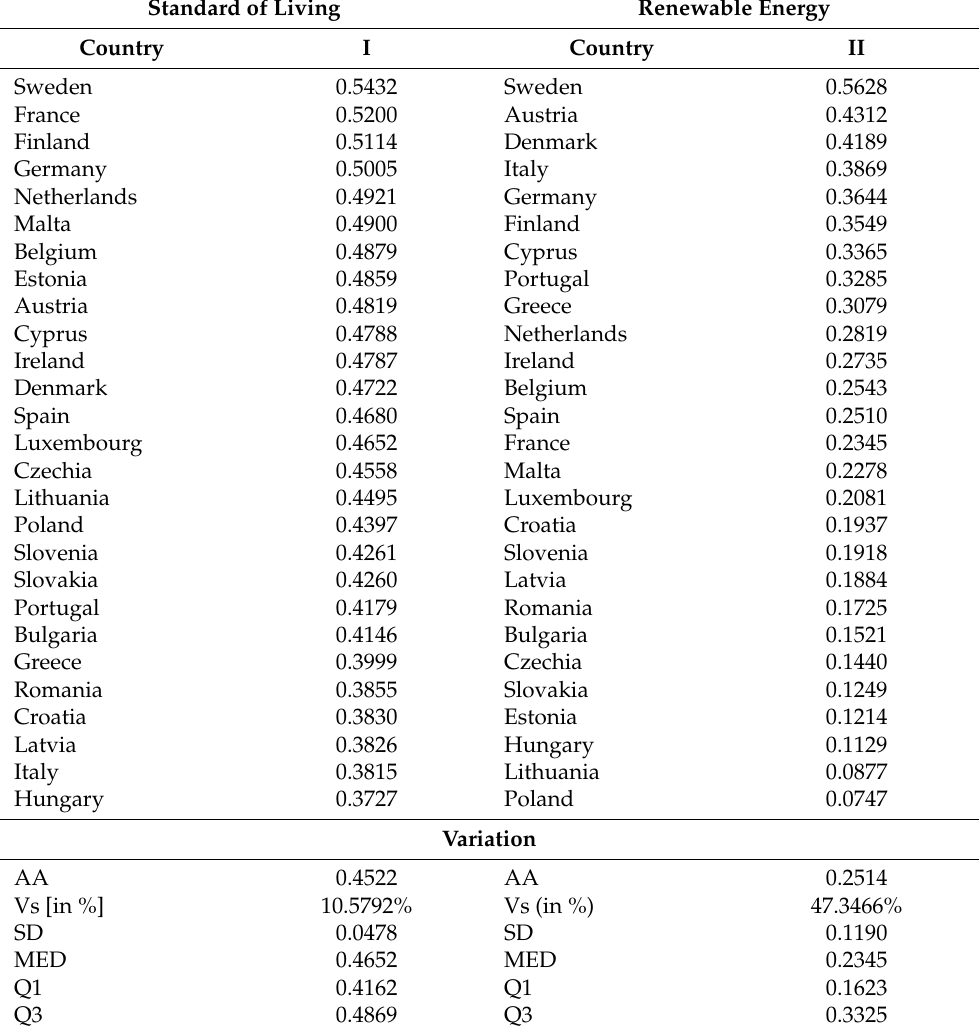
Table 3. Values of the synthetic measures of the standard of living and renewable energy develop- ment level. Standard of Living Renewable Energy Country I Country